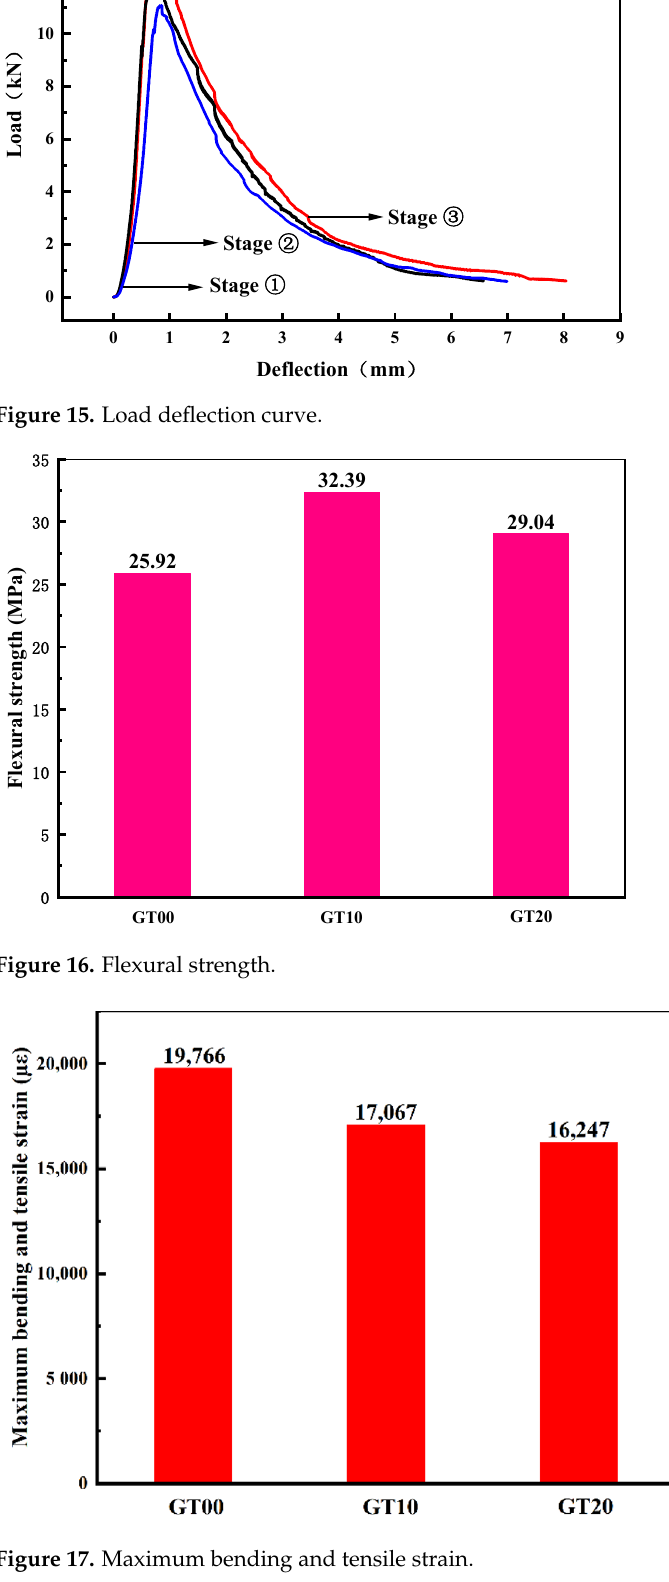
Figure 18. Flexural modulus. The flexural strength and the compressive strength were affected by the internal bonding force of the matrix. Figure 16 complies with the rule of Figure 11: the specimen achieved the maximal flexural strength under the GT content of 10%. The second half of the peak load was the stress softening stage, and the width of the main crack at the bottom of the specimen increased continuously. The deflection of GT00 is larger than that of GT10 and GT20 under the same load; the cracks in GT00 cannot develop in time to follow the original path and form more fine branch cracks to consume energy, which accelerates the loss of energy in GT00. The engagement force between GT and steel fiber in GT20 is not as large as that of GT10, and the ability of GT20 to resist bending and suppress defor- mation is weaker than that of GT10. (3) Ultimate failure stage. At the final fracture stage, the peak load continued to decrease and gradually approached zero. The aggregate in the cross-section of the crack was almost completely separated from the hardened cementi- tious slurry, and it lost its connection to the specimen. Both the bonding force between the steel fiber and the cementitious matrix and the friction force between the steel fiber and the specimen when it is pulled out could be vital factors for maintaining the integrity of the specimen. 1317.07